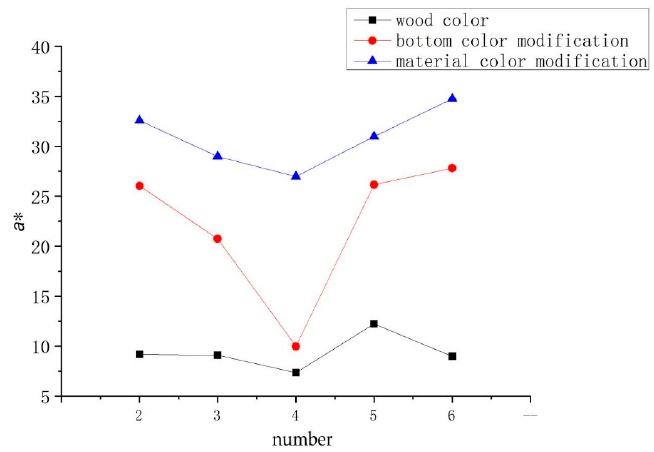
Figure 6. The effect of different surface disposition to a *.